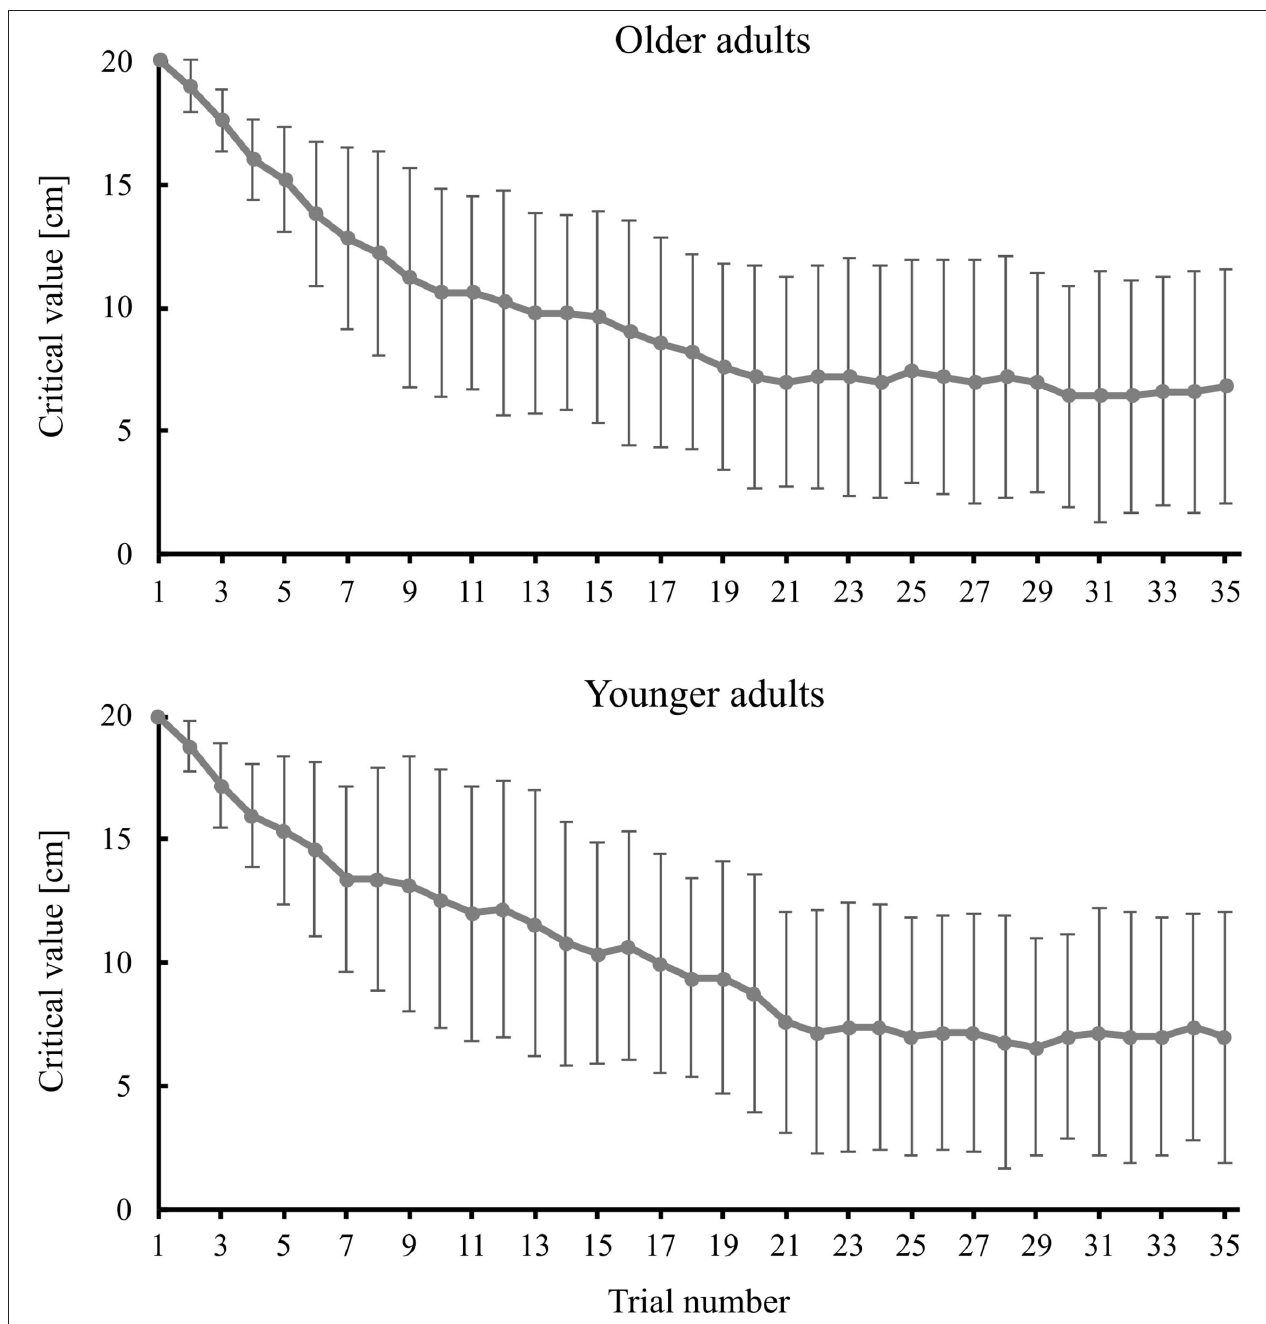
FIGURE 9 | The mean value of the critical value for older and younger adults. Error bars represent the standard deviation among